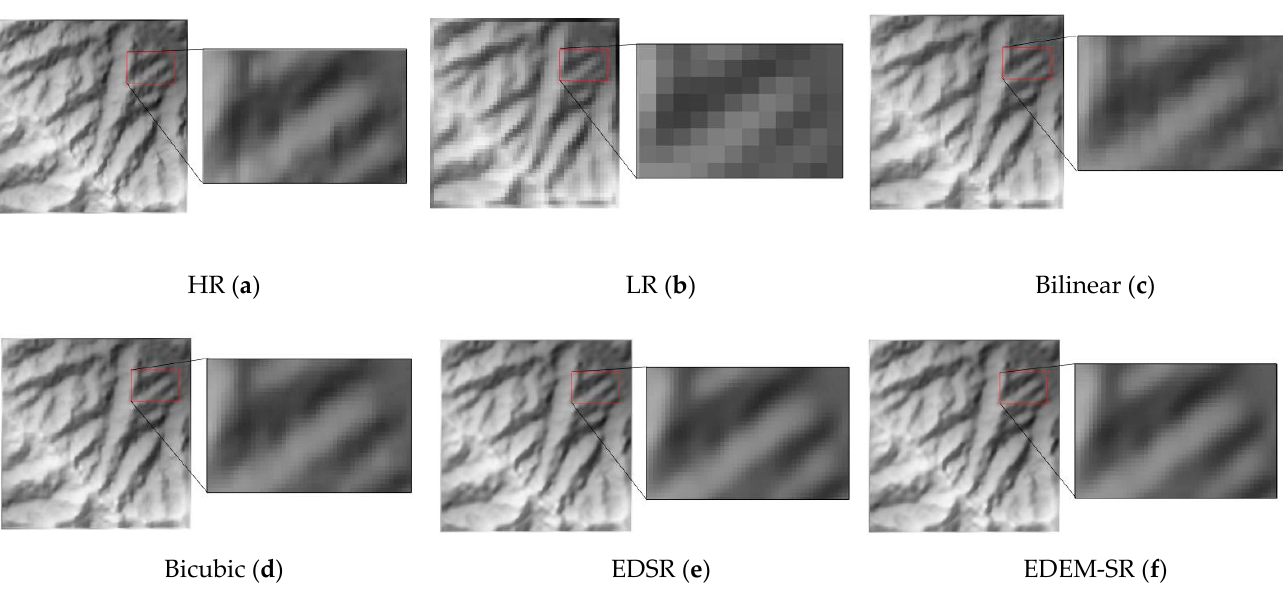
Figure 7. DEM reconstruction results: ( a ) is the high-resolution 12.5 m DEM; ( b ) is the low-resolution DEM with 50 m resolution; ( c , d ) are the bilinear and bicubic results; ( e ) is the EDSR result, and ( f ) is the EDEM-SR result. The above reconstruction results were all generated using an up-scaling factor of 4.